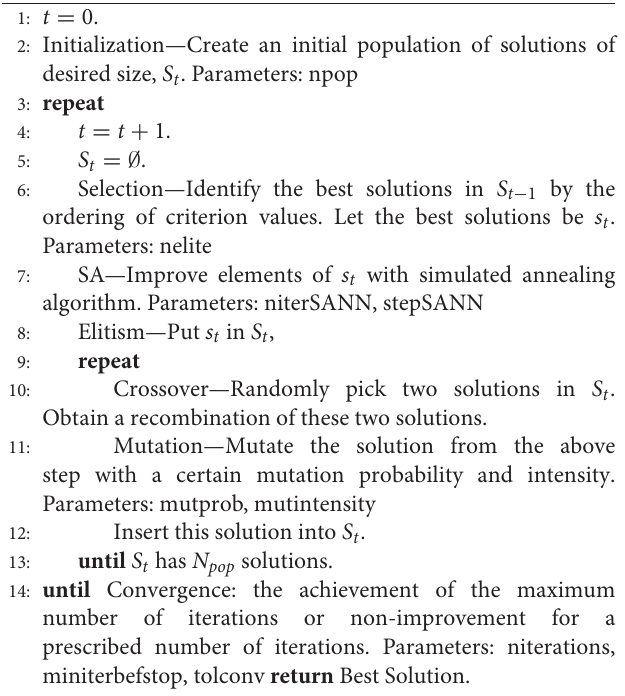
Algorithm 1 : Combinatorial optimization algorithm in